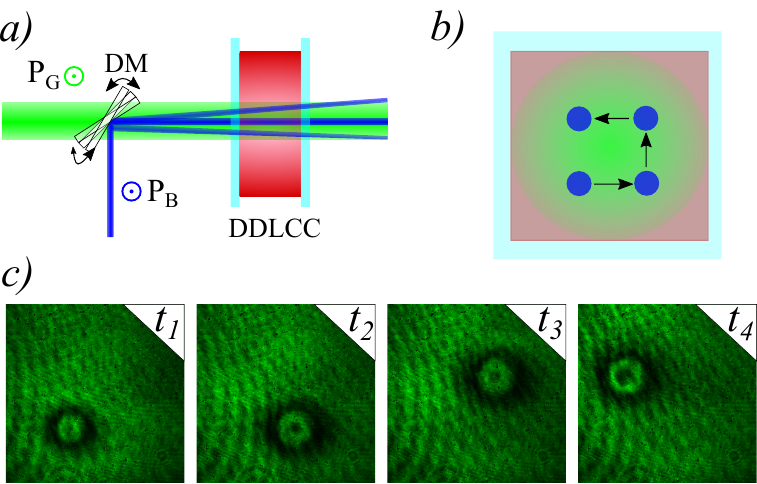
Figure 8. Manipulable ring patterns induced by illumination on a dye-doped liquid crystal sample. ( a ) Schematic representation of the mechanism for applying the light beam to the dye-doped liquid crystal sample. ( b ) Schematic representation of the path made by the light beam by adjusting the pitch and yaw of the dichroic mirror. ( c ) Snapshots of ring patterns observed at different times ( t 1 < t 2 < t 3 < t 4